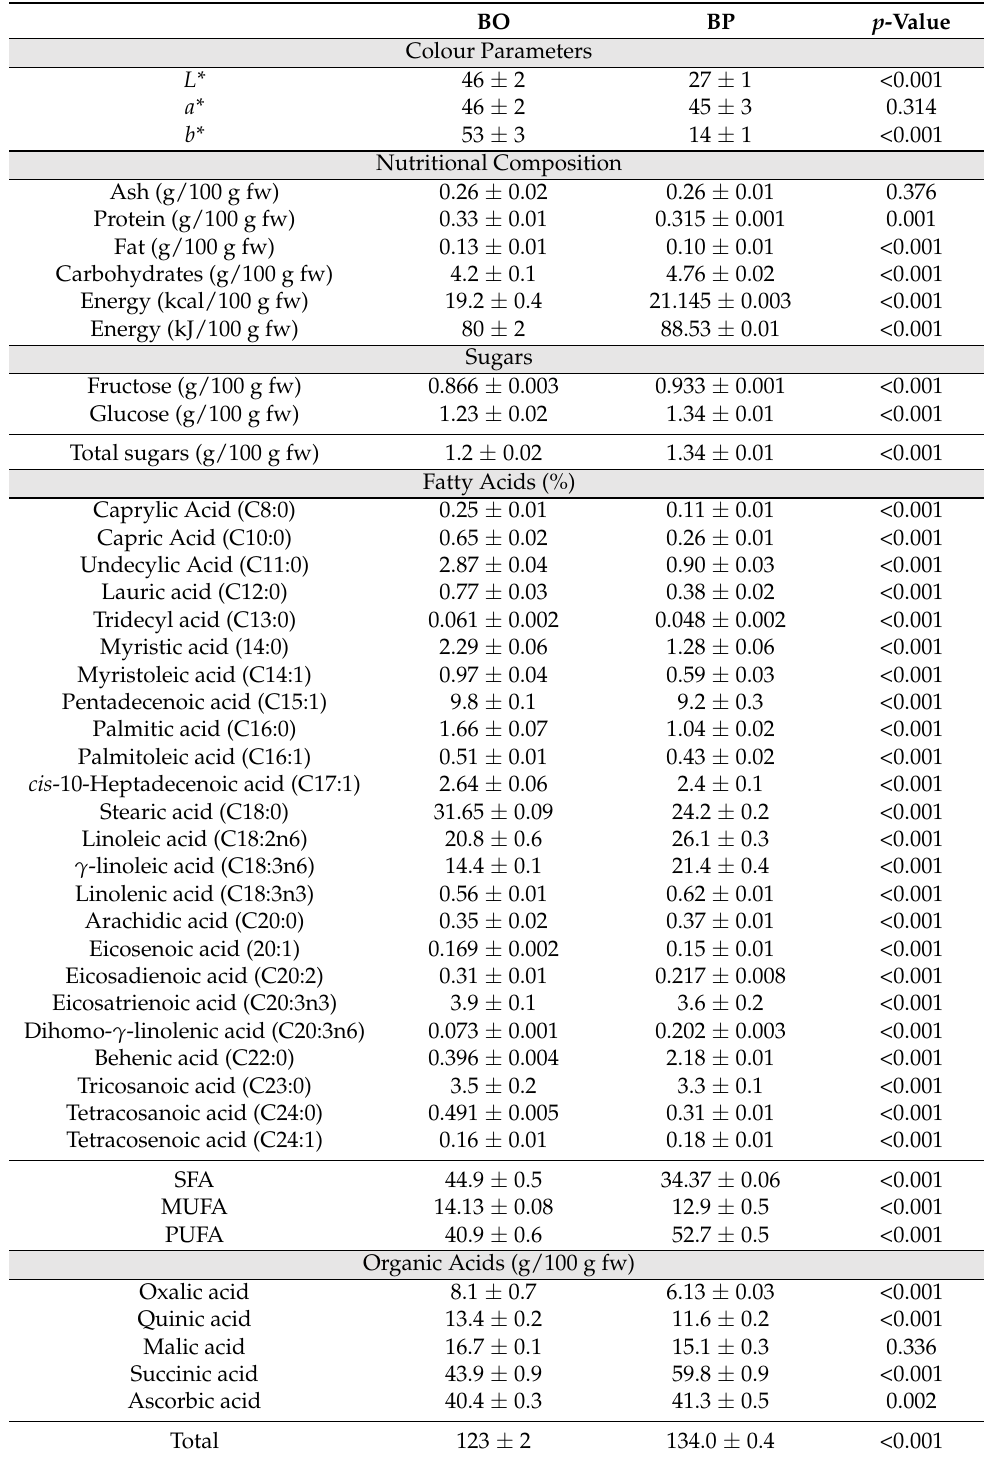
L * luminosity; a * chromatic axis from green (-) to red (+); b * chromatic axis from blue (-) to yellow (+); fw— fresh weight, dw—dry weight; SFA—Saturated fatty acids; MUFA—Monounsaturated fatty acids; PUFA— Polyunsaturated fatty acids. Standard calibration curves: oxalic acid (y = 1E + 07 x + 231.891, R 2 = 0.9999); quinic acid (y = 671.557 x + 14.583, R 2 = 0.9998); malic acid (y = 950.041 x + 6255.6, R 2 = 0.9999); succinic acid (y = 640.365 x − 17.602, R 2 = 0.9995) and ascorbic acid (y = 4E + 07 x + 1E + 06, R 2 =